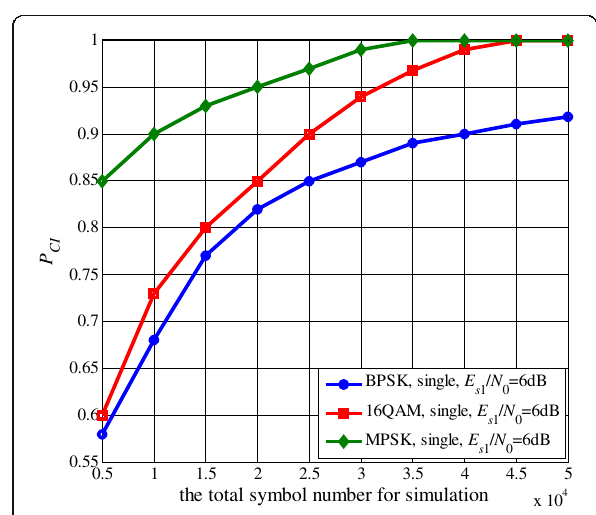
Fig. 6 The P CI as a function of the total symbol number for